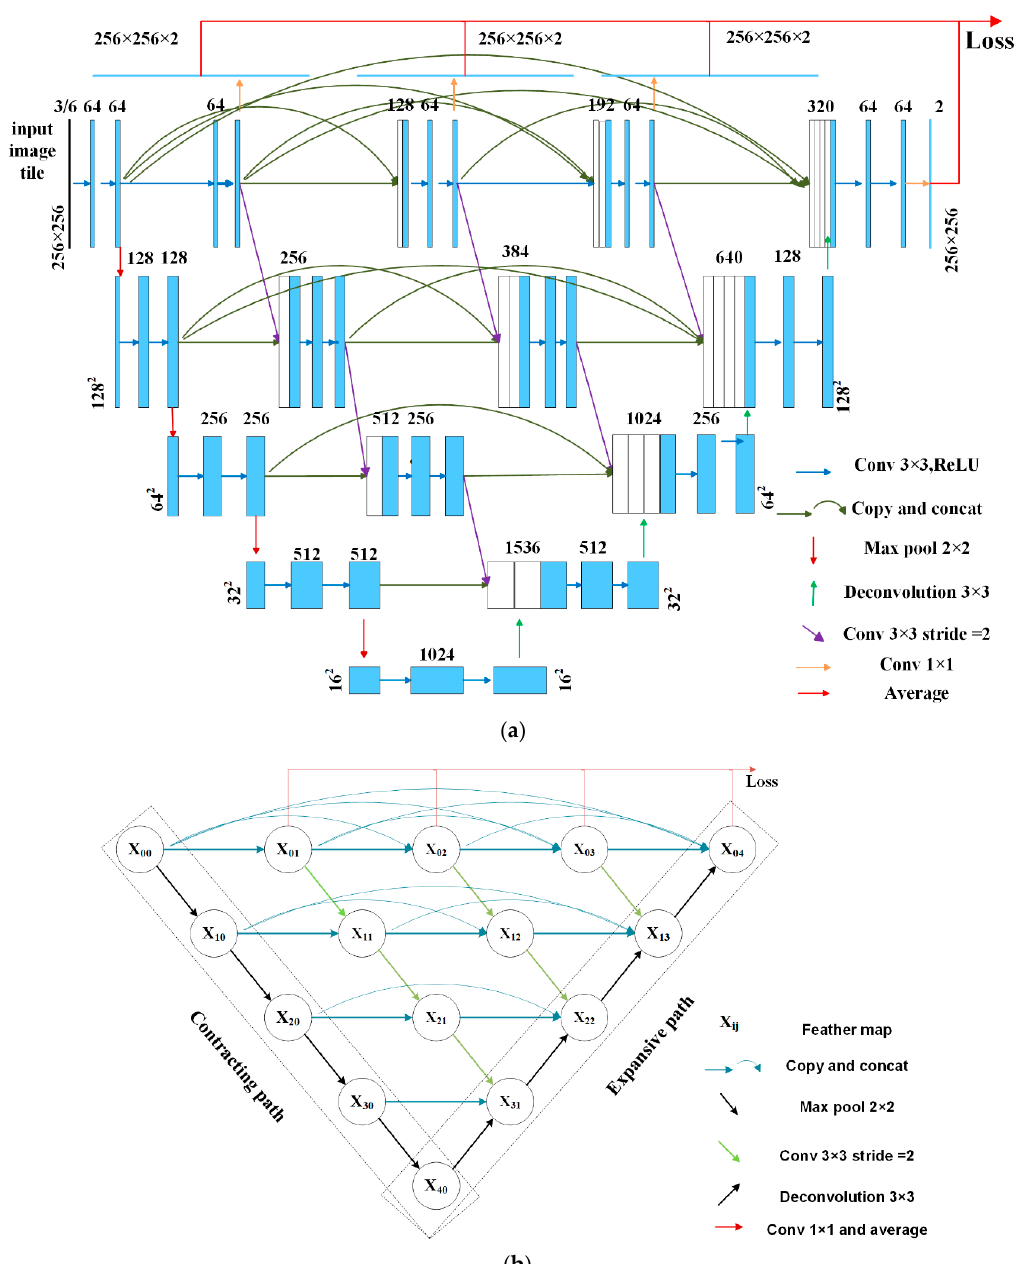
Figure 4. ( a ) The HRU-Net architecture and ( b ) the simplified topology diagram of the HRU-Net.